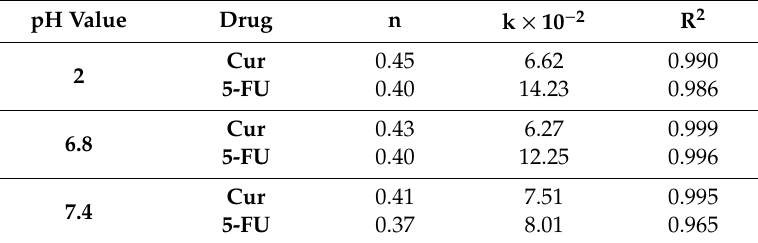
Table 3. Basic kinetic parameters of the process of Cur and 5-FU kinetics released from PMs using the Ritger–Peppas kinetic